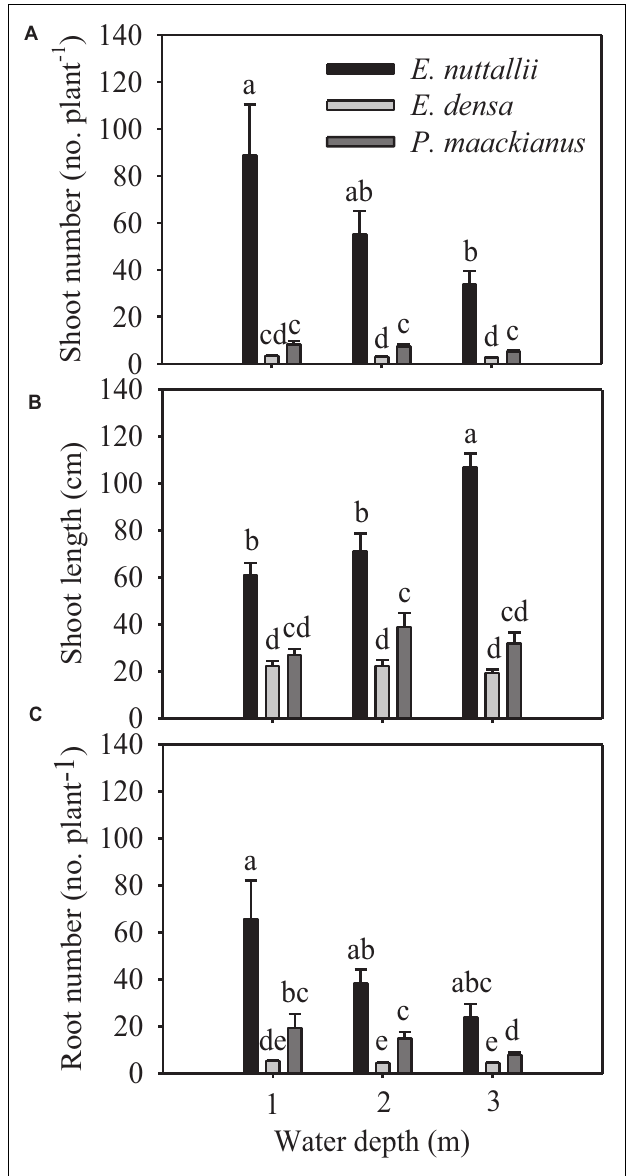
FIGURE 2 | Changes in the morphological traits (shoot number A , shoot length B , and root number C ) of the three macrophytes, data are presented as the means ± 1SE ( n = 7). Means with different small letters are significantly different at P < 0.05 among different treatments.